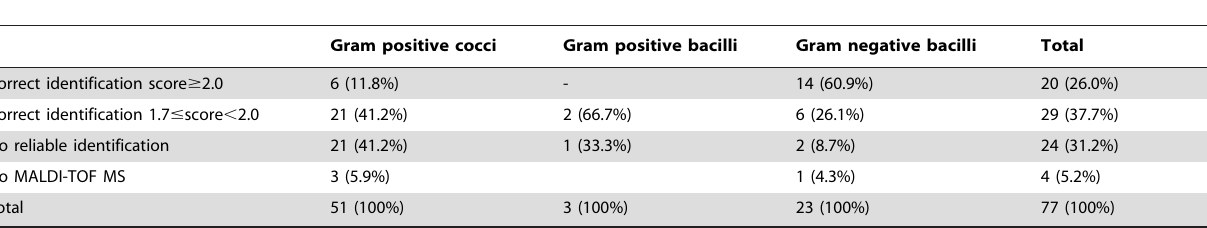
Table 1. Number of correct and incorrect direct MALDI-TOF MS identification in 77 monomicrobial episodes.